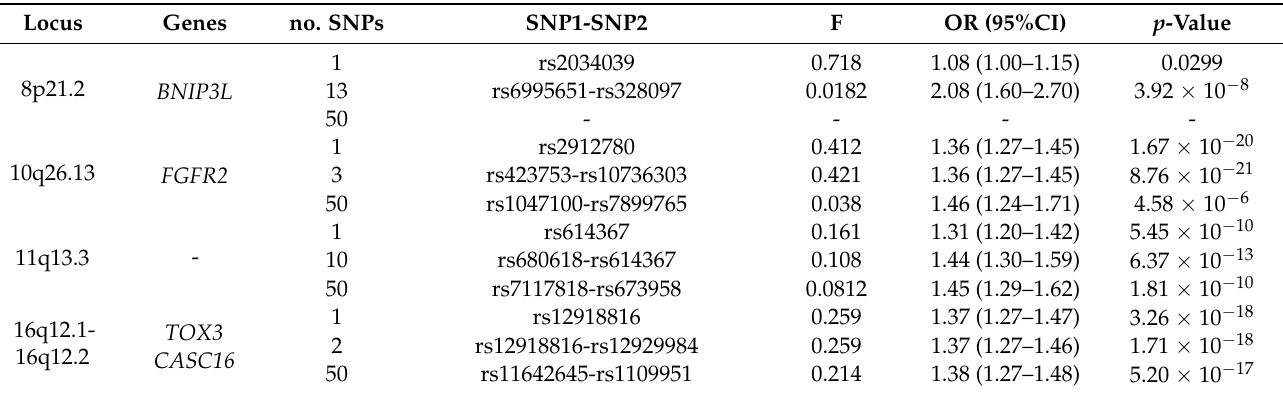
Table 1. SNPs and haplotypes (window size 2–25 and 50) with lowest p value in four risk loci on Chromosome 8, 10, 11 and